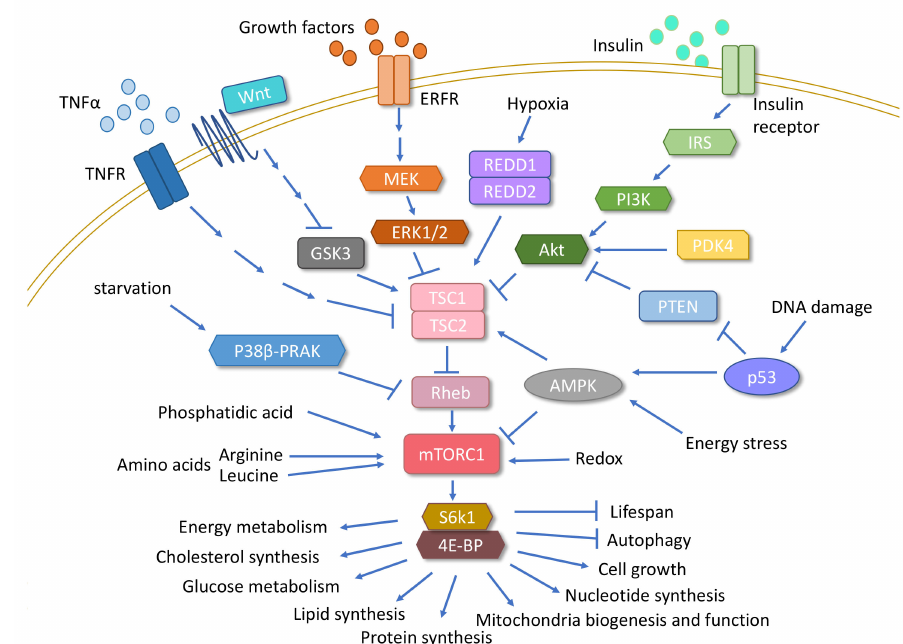
Figure 2. The main signaling pathways associated with mammalian target of rapamycin (mTOR). mTOR integrates inputs from multiple sources including growth factors, insulin, stress, energy balance, oxygen, and nutrients, and it controls many major downstream processes, including metabolism, macromolecule synthesis, mitochondria function, cell growth, and